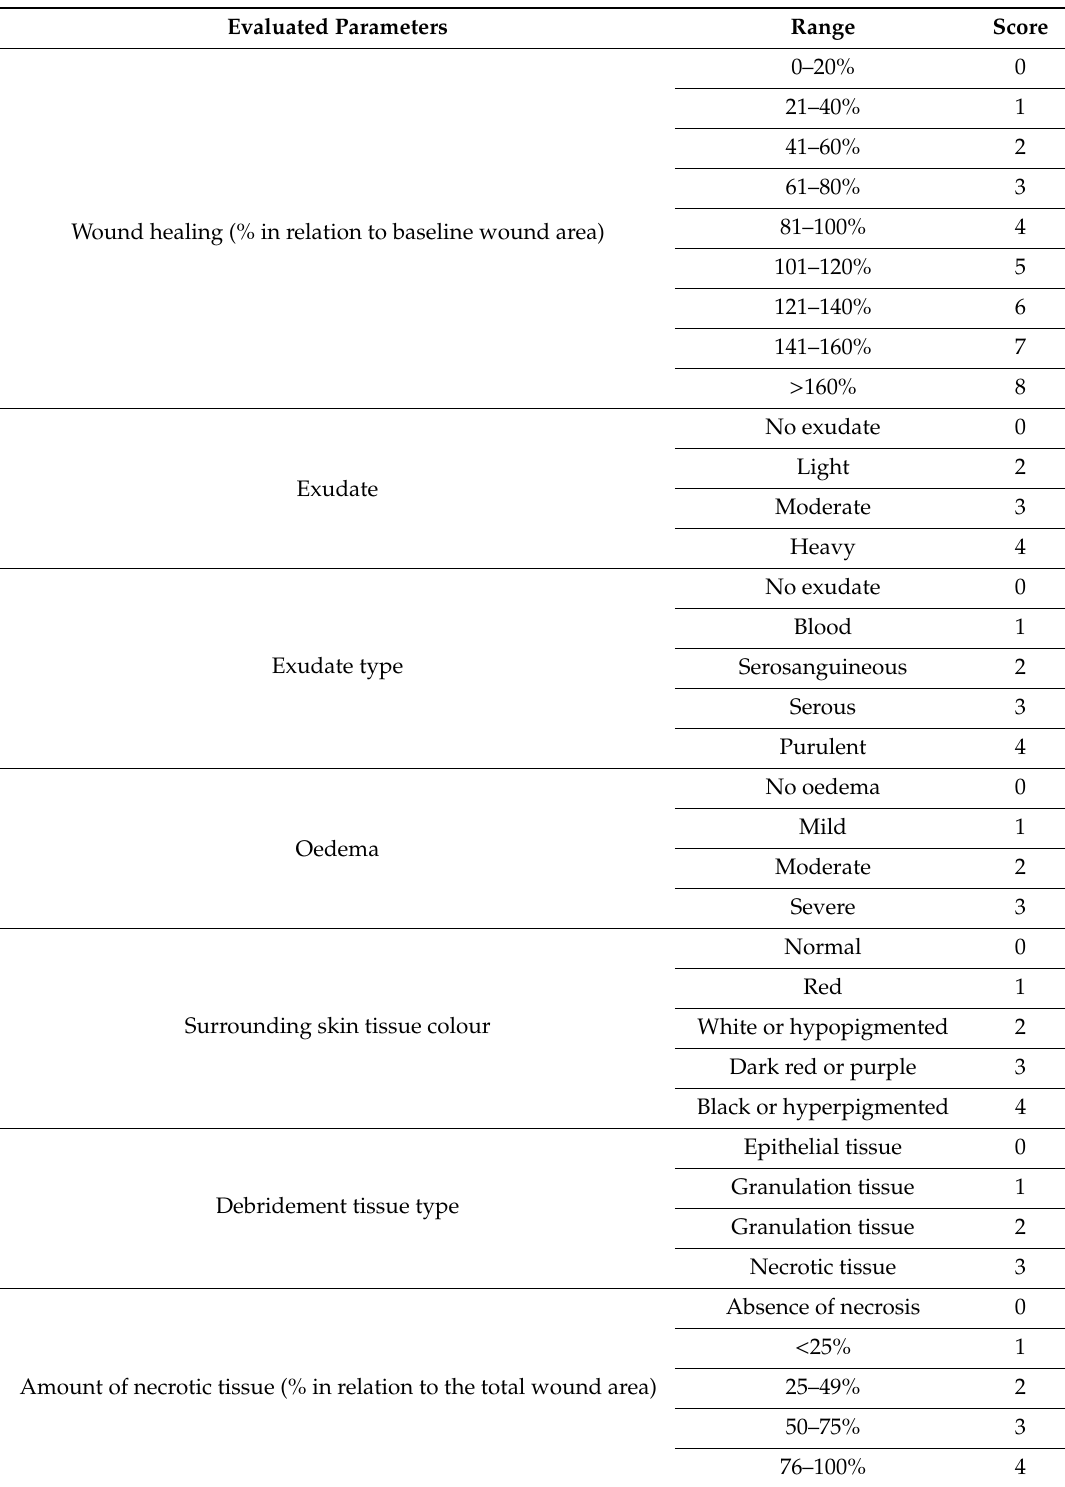
Table 2. Macroscopic evaluation of the